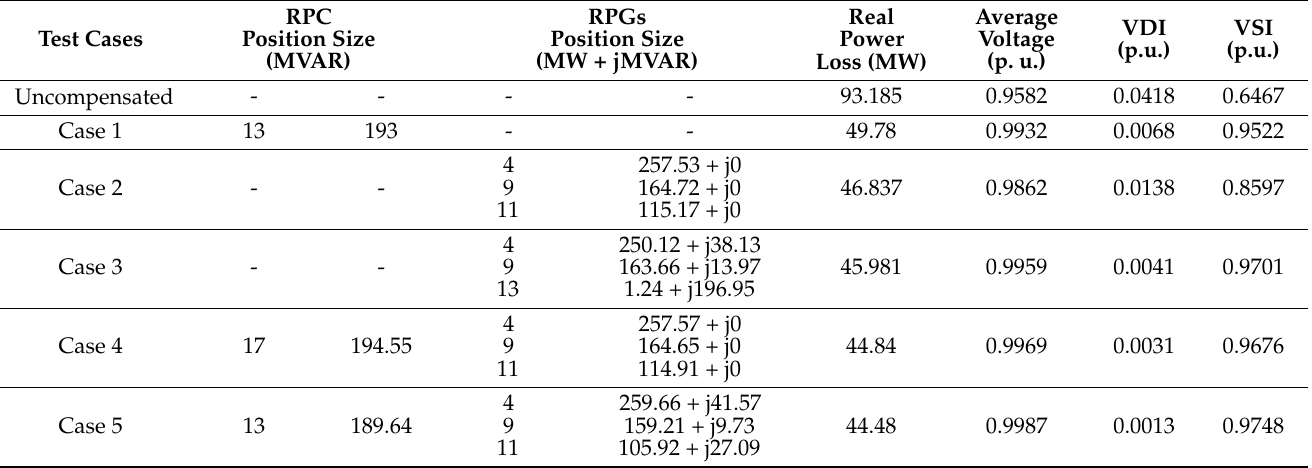
Table 8. Summary of test